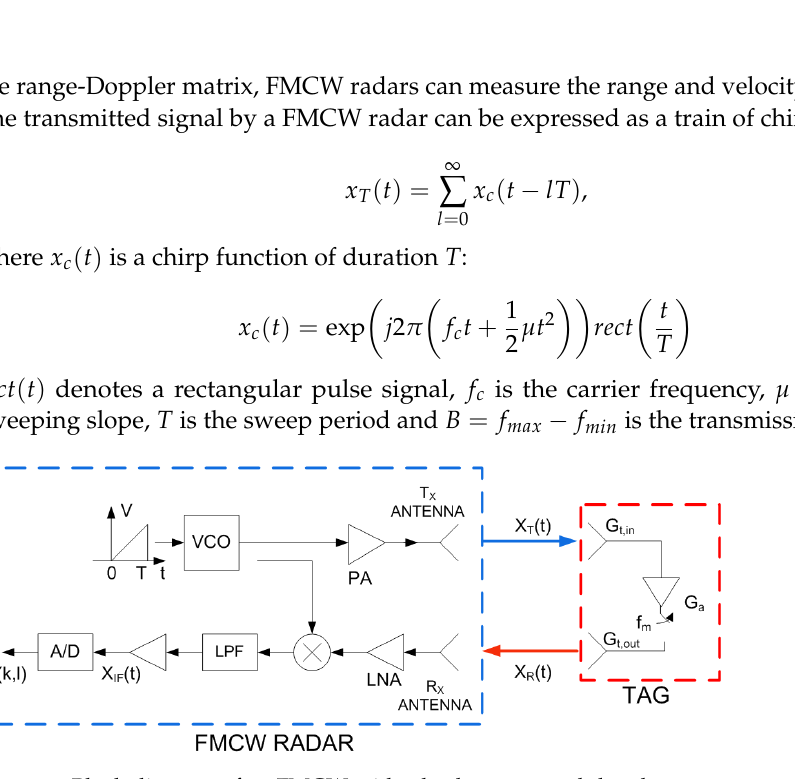
Figure 5. Block diagram of an FMCW with a backscatter modulated